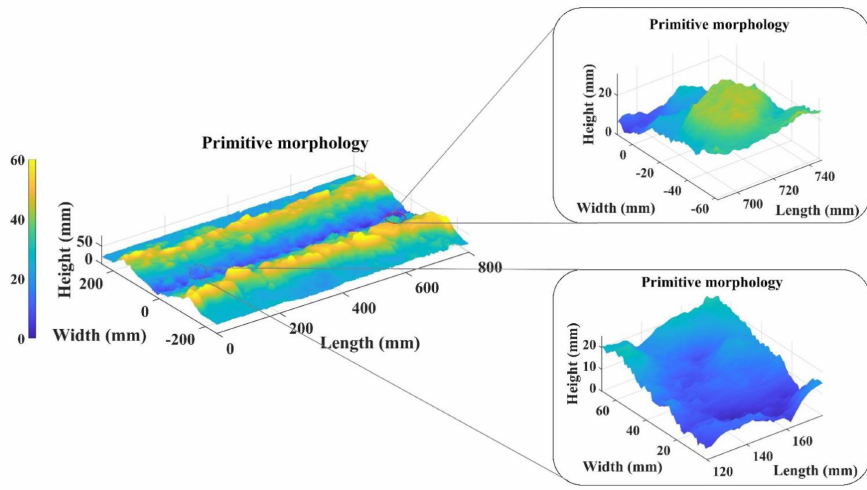
Figure 12. Concave and convex areas intercepted by 3D digital model of original surface.